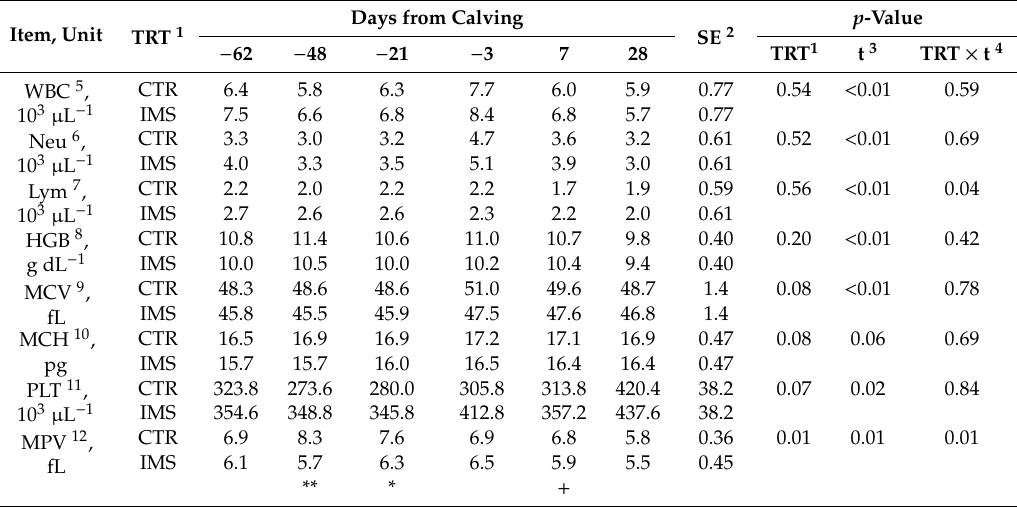
Table 4. Blood cells profile in control dairy cows (n = 5) or cows receiving 65 g*d − 1 of Omnigen-AF ® as top-dress between − 55 and 42 days from calving (n = 5).